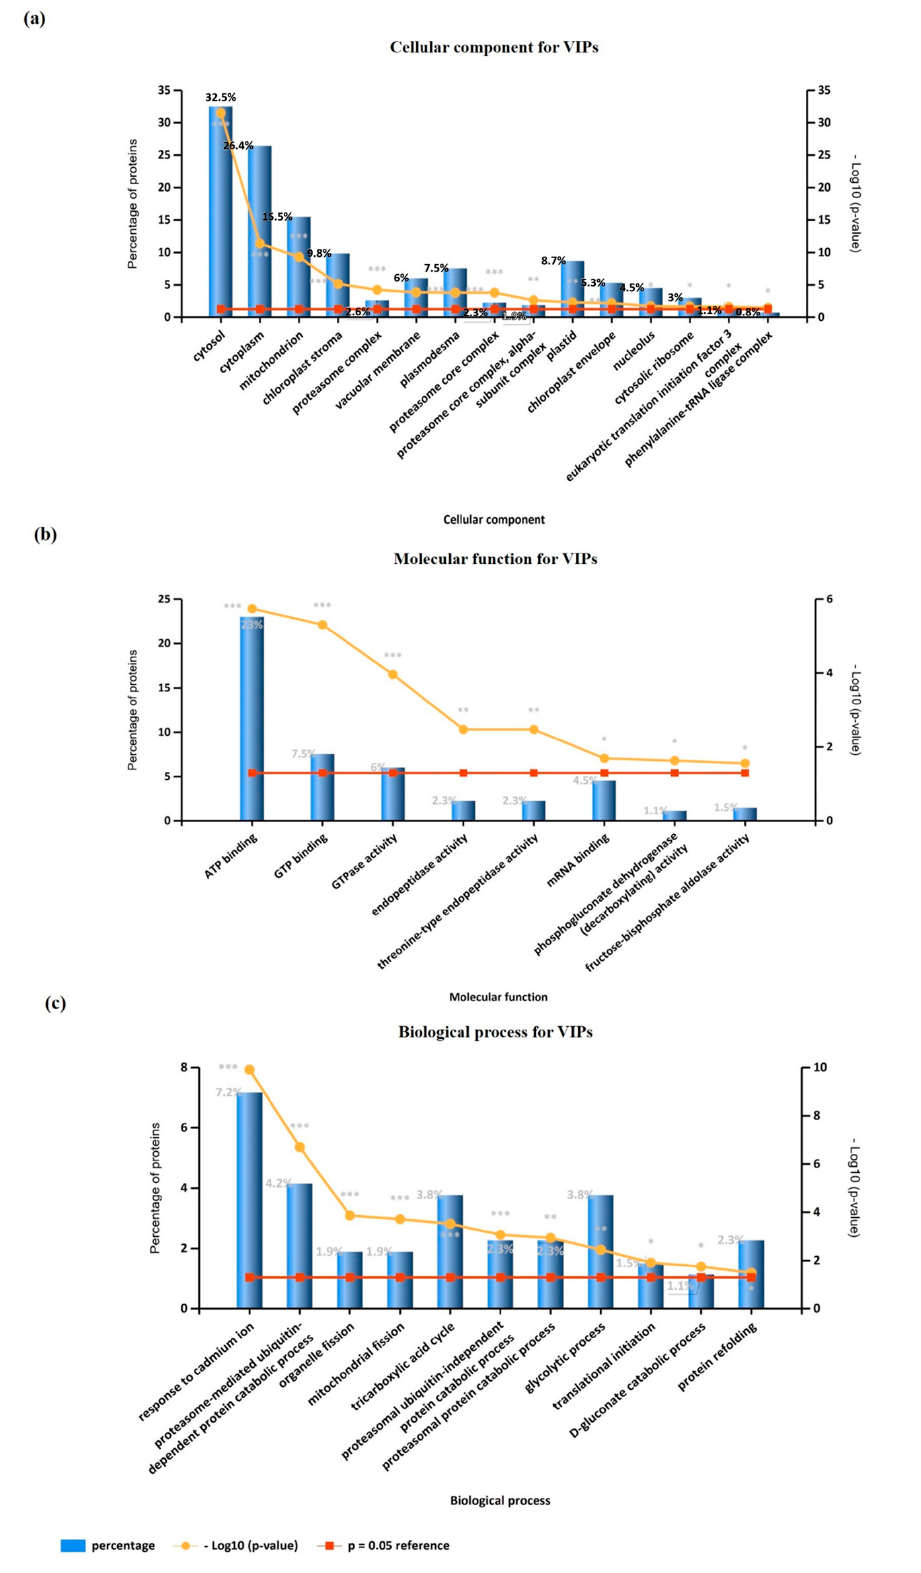
Figure 2. Gene ontology enrichment analysis of the 267 VIP proteins, selected by PLS-DA analysis, performed using FunRich and the Plants database from UniProt database: ( a ) cellular component; ( b ) molecular function, and ( c ) biological process. *: p < 0.05; **: p < 0.01 ***: p < 0.001.